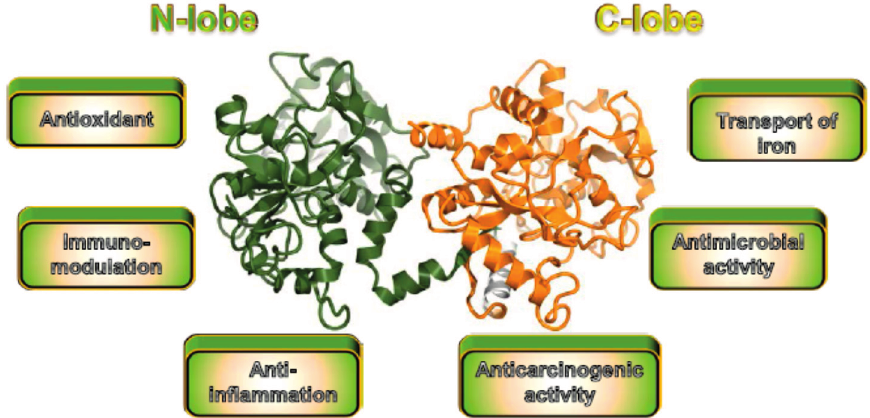
Figure 2. Crystal structure of bovine lactoferrin and its biological functions. Bovine lactoferrin consists of two lobes, an N-lobe (green) and a C-lobe (orange). The crystal structure was prepared using the CueMol software and the structural coordinates of PDB